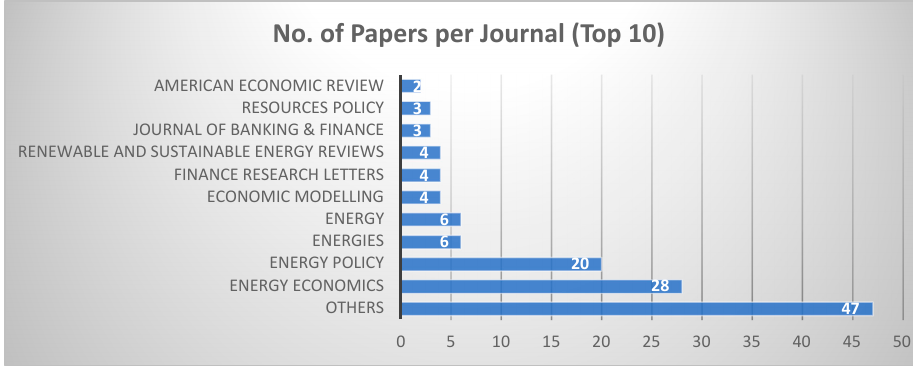
Figure 3. Number of Papers per Journal (Top 10 Included). Table 1. Number of Papers per Journal.